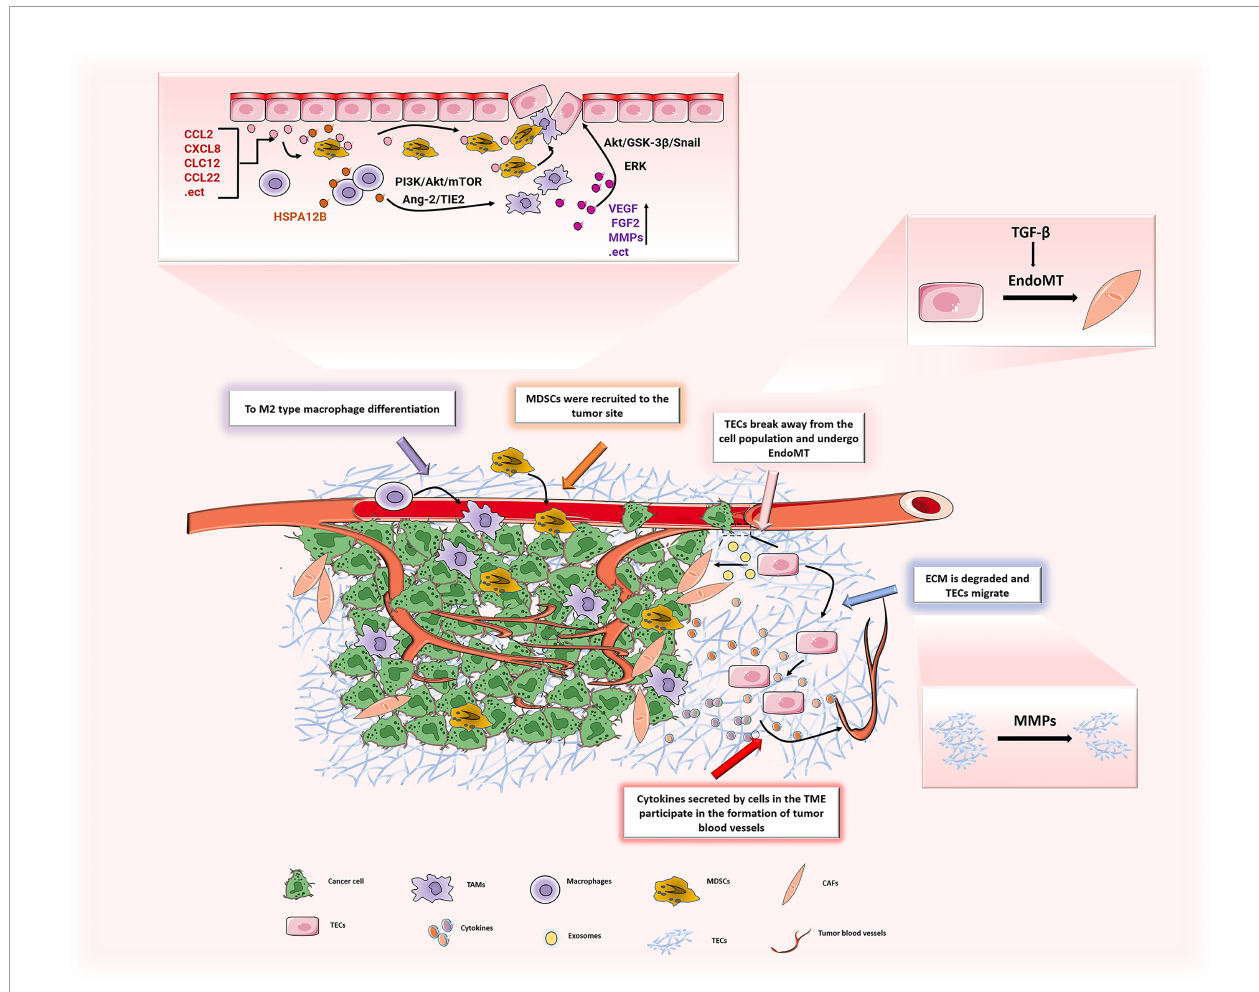
FIGURE 5 | In TME, the various components interact to promote the development of ECs in the direction of promoting angiogenesis. ECs can induce M2 polarization of macrophages through PI3K/Akt/mTOR, and may recruit TAMs to tumor sites through the Ang-2/TIE2 signaling pathway to promote tumor progression. TAMs secrete a large number of pro-angiogenic factors (VEGF, FGF2, MMPs, etc.) to promote the proliferation of ECs, leading to tumor angiogenesis. The chemokines (CCL2, CXCL8, etc.) secreted by ECs recruit MDSCs to the tumor and play a tumor-promoting effect. ECs generate CAFs through EndoMT, and the generated CAFs secrete pro-angiogenic factors to stimulate ECs and promote tumor angiogenesis. After ECM is degraded by MMPs, it increases the migration of ECs and promotes tumor